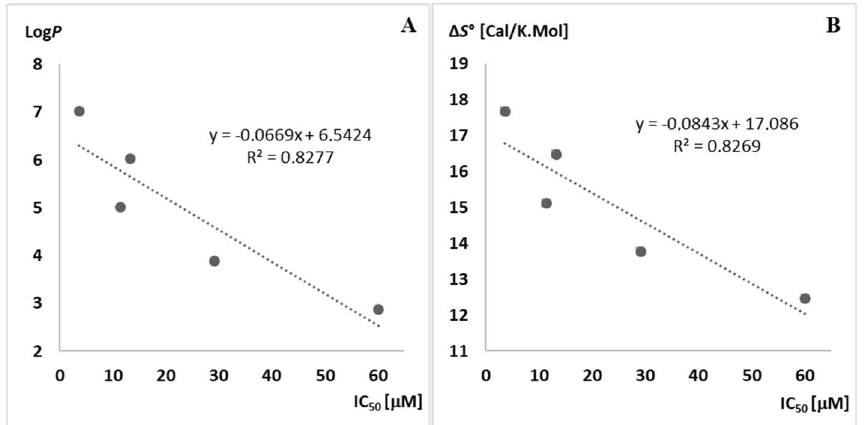
Figure 4. ( A ). Relationship of the inhibition concentration IC 50 and the lipophilicity Log P . ( B ). Relationship of the inhibition concentration IC 50 and the change in the standard entropy Δ S °. The value of the lipophilicity Log P was determined using the Molinspiration software program (molinspiration.com). The value of the inhibition concentration IC 50 of ureas 11j – 11n against HeLa cancer cell lines is given as a micromolar concentration. The value of the change in the standard entropy Δ S ° of ureas 11j – 11n given in cal.mol − 1 . K − 1 was obtained using the PM7 method.